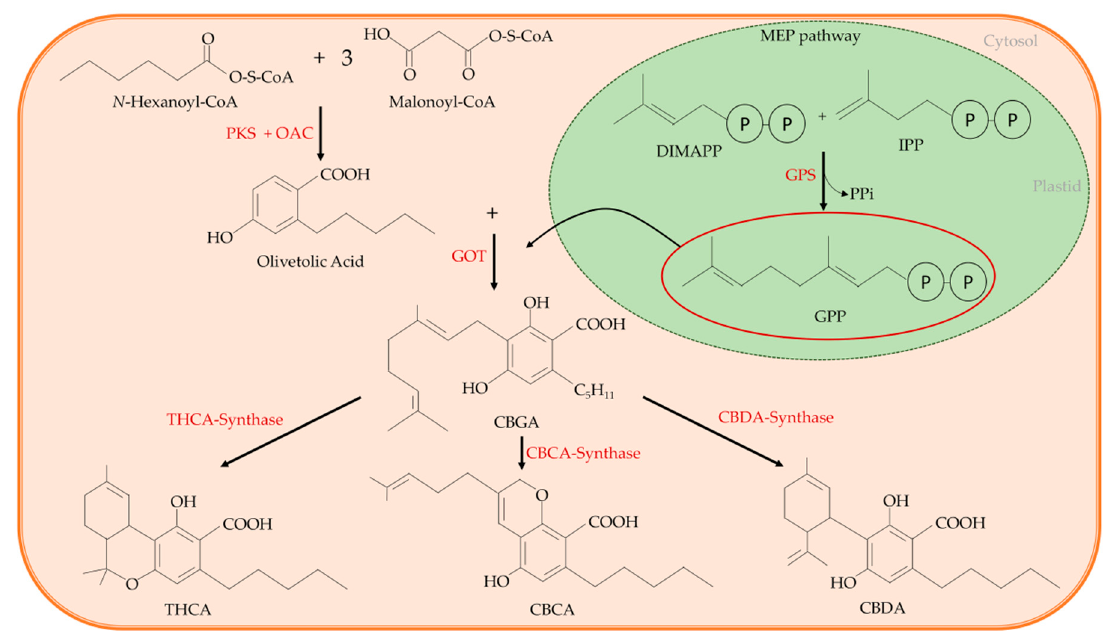
Figure 2. The cannabinoid synthetic pathway: cannabigerolic acid (CBGA) is the common precursor of all main cannabinoids. It is synthesized through an alkylation of the phenolic moiety of olivetolic acid with the terpenoid component of geranyl pyrophosphate (GPP). The reaction is catalysed by a geranylpyrophosphate:olivetolate geranyltransferase (GOT). Olivetolic acid is originated in the cytosolic polyketide pathway through an aldol condensation of hexanoyl-Coenzyme A (CoA) with three molecules of malonyl-CoA, that is catalysed by the polyketide synthase (PKS) enzyme in the presence of olivetolic acid cyclase (OAC). The GPP is synthesized by the plastidial methylerythritol phosphate (MEP) pathway. In the cytosol, CBGA is converted into the acidic form of the three main cannabinoids, tetrahydrocannabinol acid (THCA) that in the acidic form has no psychoactive activity, cannabidiolic acid (CBDA) and cannabichromenic acid (CBCA). GPS: geranyl pyrophosphate synthase; IPP: isopentenyl diphosphate; OAC: olivetolic acid cyclase.